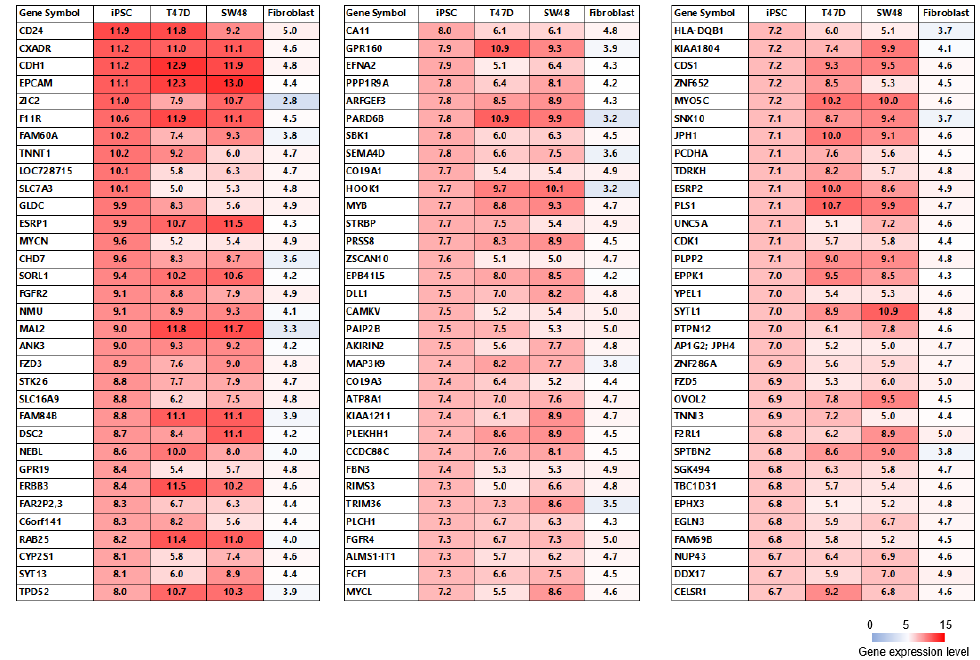
Figure 3. Heatmap analysis of gene expression of iPSCs, SW48 and T47D cells, and fibroblasts. The iPSC data were obtained from microarray analysis. The SW48 and T47D cell and fibroblast data were obtained from the NCBI GEO database. The listed genes are highly expressed in iPSCs and are very lowly or not expressed in fibroblasts (gene expression level < 5). The change from red to light purple indicates the gene expression level changing from 15 to 0. The 99 genes in the list were selected in order of highest gene expression in the iPSCs.